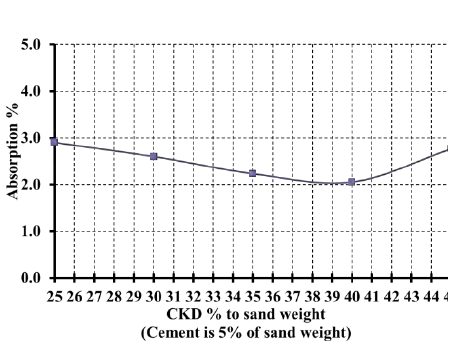
Figure 25. Dry Density